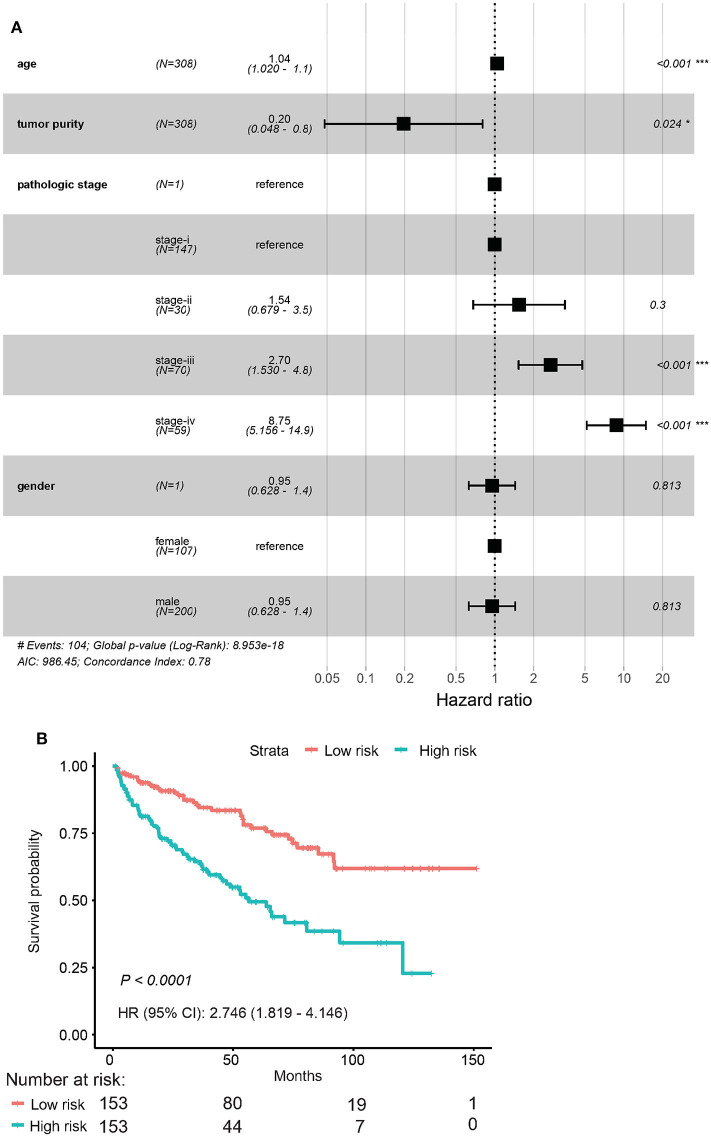
Evaluation of the 12-gene model. (A) Evaluation of hazard ratios by clinical traits. (B) Time–dependent ROC curve for high risk and low risk.